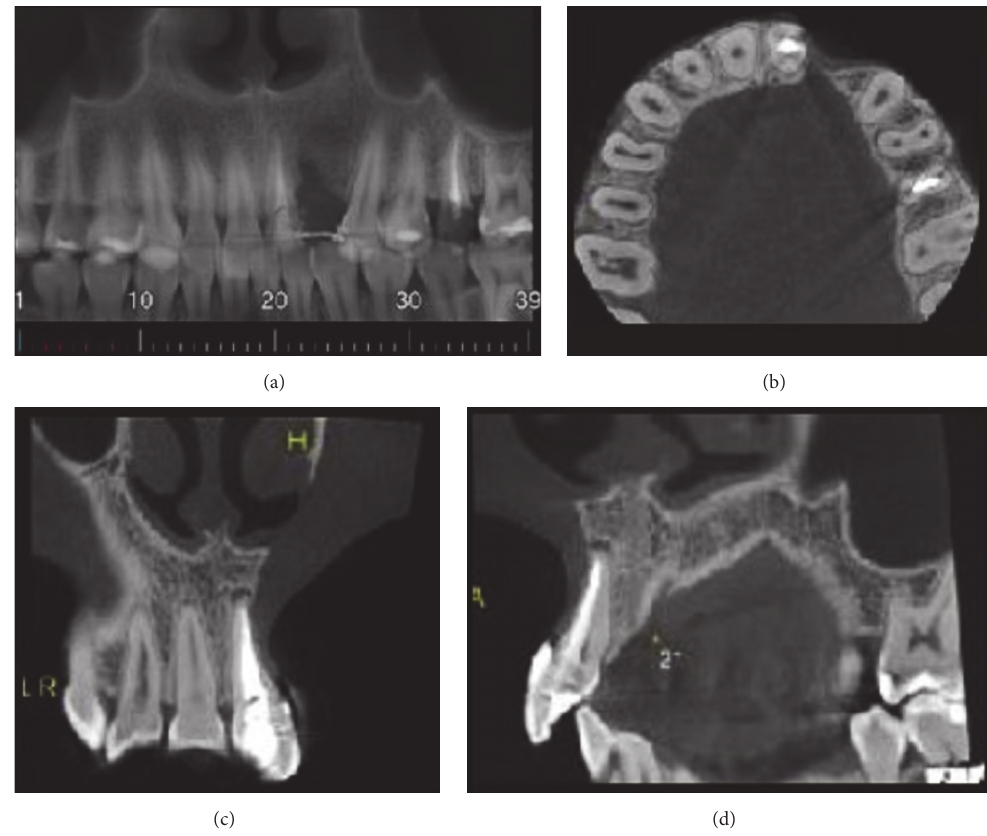
Figure 3: (a) CT panoramic reconstruction of maxilla. (b) CT axial reconstruction of the jaw. (c) CT coronal reconstruction of anterior region of maxilla. (d) CT sagittal reconstruction of tooth 11